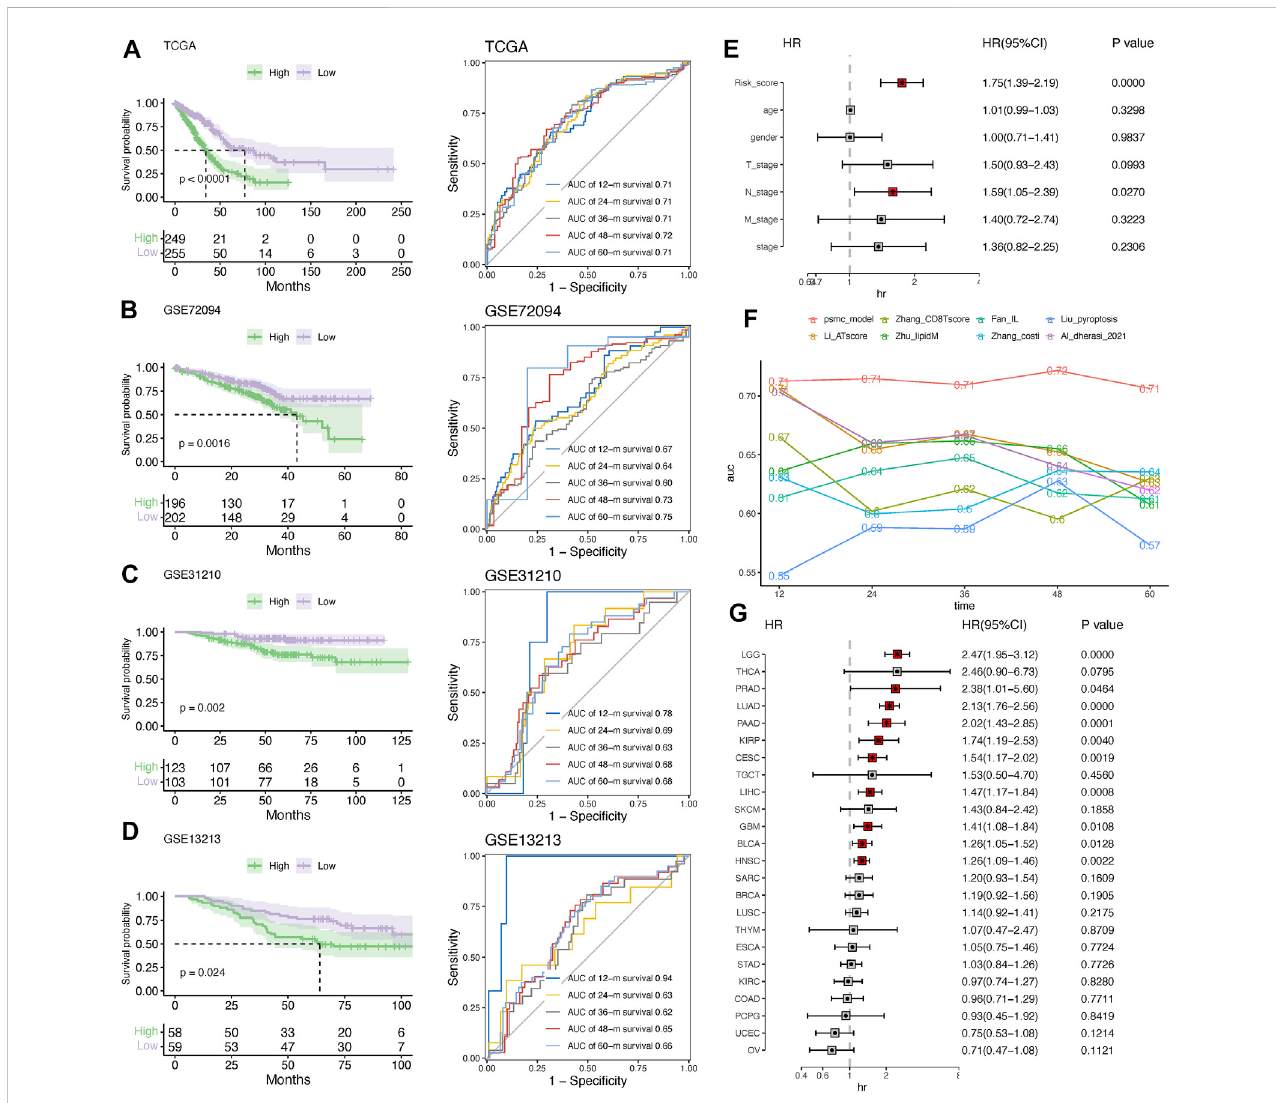
FIGURE 5 Evaluation and validation of the risk signature. Kaplan – Meier survival analysis and time-dependent ROC curves at 1 – 5 years in the training (A) and validation cohorts, including GSE72094 (B) , GSE31210 (C) , and GSE13213 (D) . (E) Multivariate Cox regression analysis of the hazard ratio (HR) of the PSMC risk score and other clinicopathological features in the training cohort. (F) Comparison of the predictive accuracy for 1- to 5-year survival between the PSMC signature and previously reported risk signatures in LUAD. (G) Forest plot showing the HR of the PSMC risk score from the TCGA dataset in